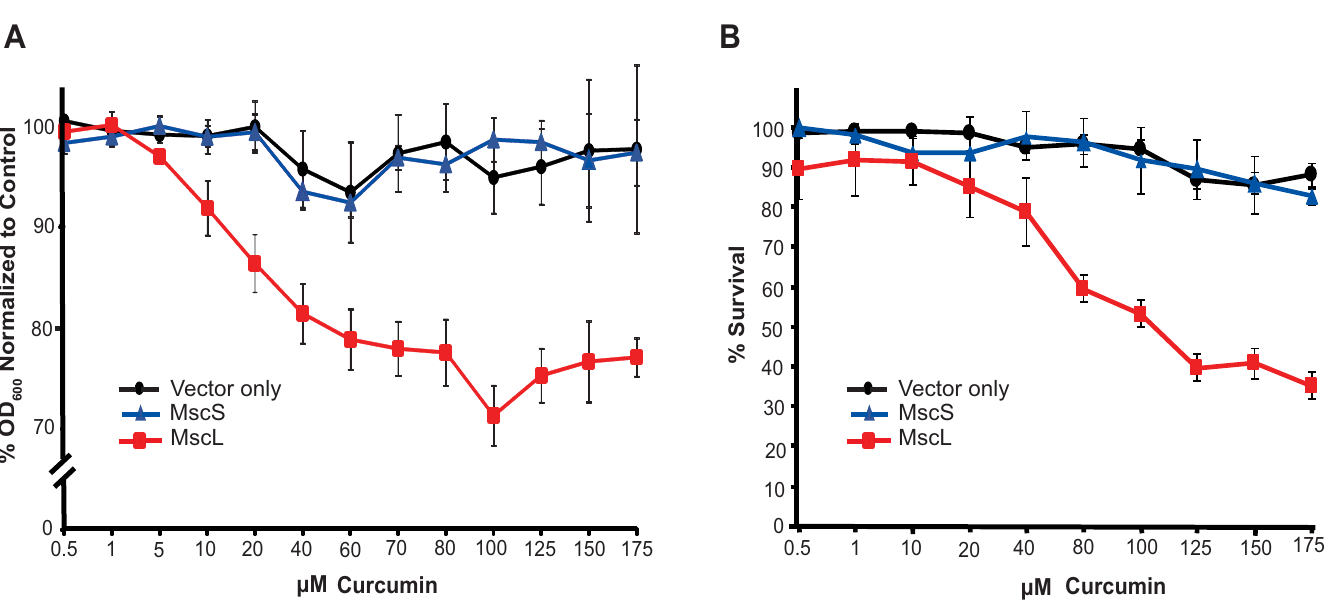
Fig 1. Curcumin inhibits growth and reduces viability in a MscL-dependent manner. Shown is the E . coli strain MJF455 ( Δ MscL, Δ MscS) carrying vector only (black circles) or expressing MscS (blue triangles) or MscL (red squares). A) Percentage of decreased growth after treatment with curcumin (OD 600 ) relative to untreated are shown. B) Reduction in viability after curcumin treatment shown as percent decrease in CFU’s relative to untreated. n = 3–5 and. error bars show standard error of the mean (SEM).